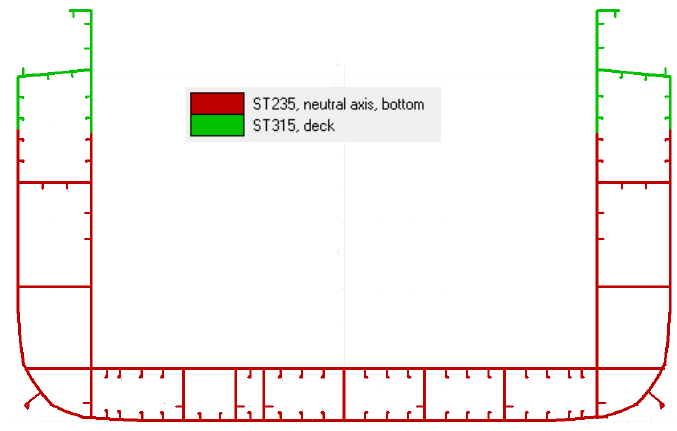
Figure 1. Midship section and material distribution.